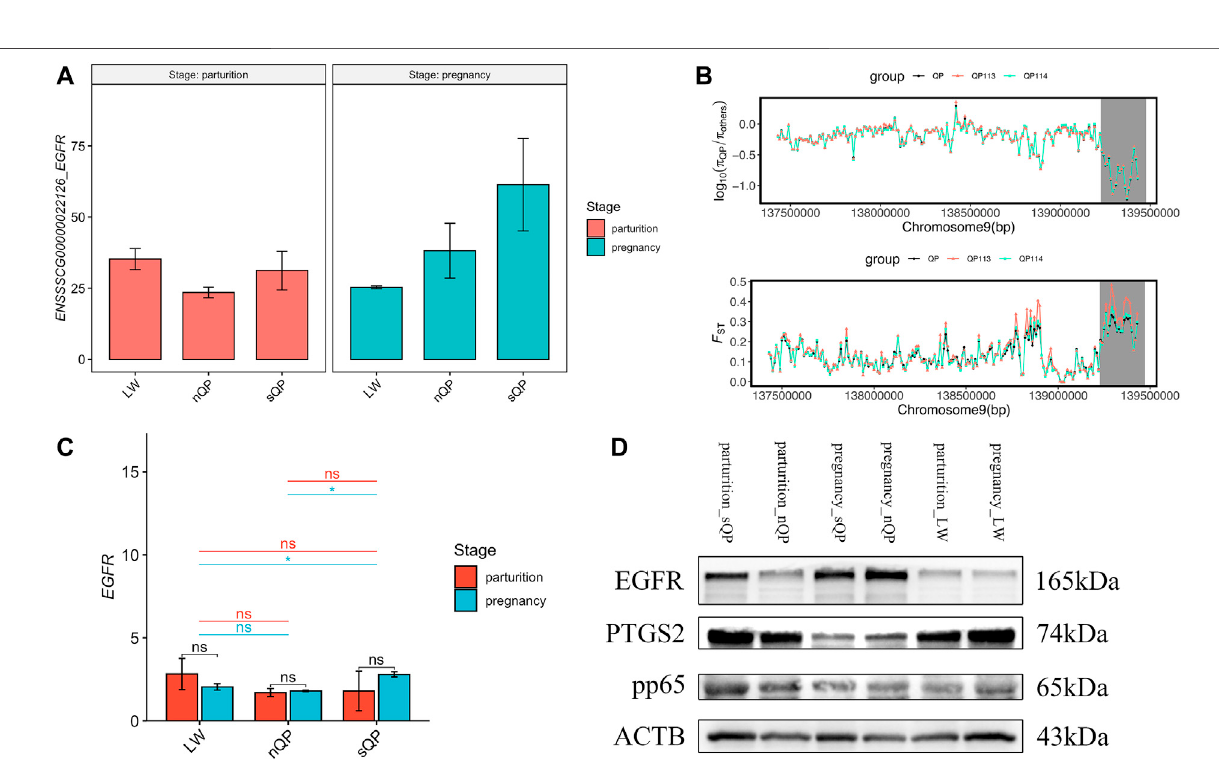
Frontiers in Genetics |